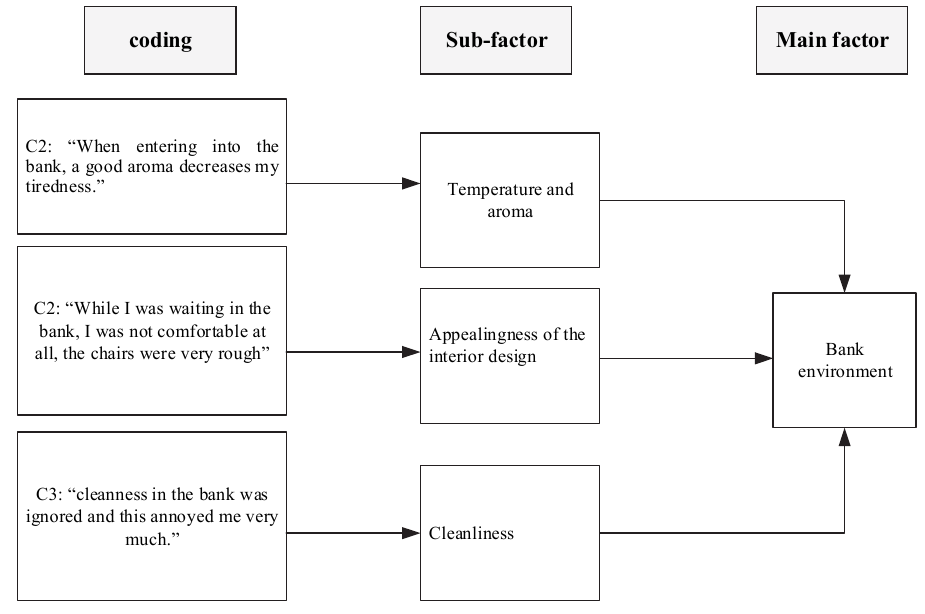
Fig 1. Theme extracted from some